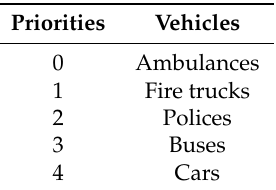
Table 3. Traffic light priority.